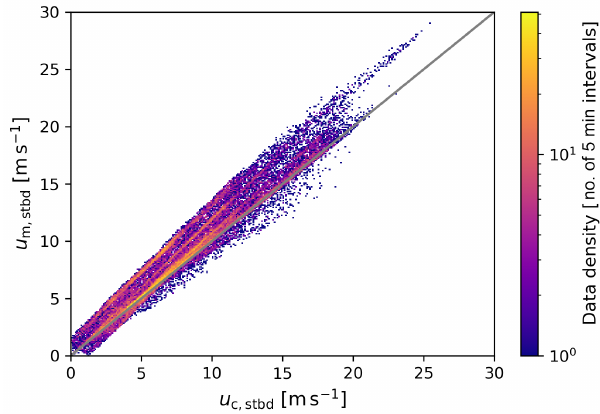
Figure 6. Weighted bin average ratio of S m , port to the expected S M (based on ERA-5) as a function of D m , port . The weighted bin averages are shown for the whole ACE cruise (black) as well as for the ship’s location south of 60 ◦ S (pink line), between 40 and 60 ◦ S (blue line), and north of 40 ◦ S (orange line). The shaded area denotes the standard deviation of the weighted mean.